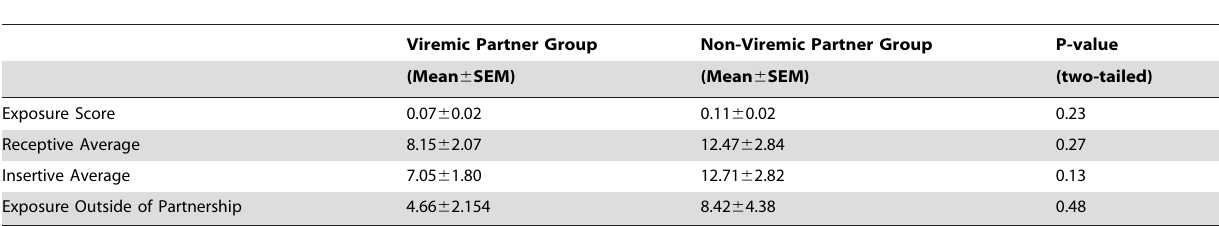
Table 2. Sexual exposure and direction of exposure to a partner between the two groups.